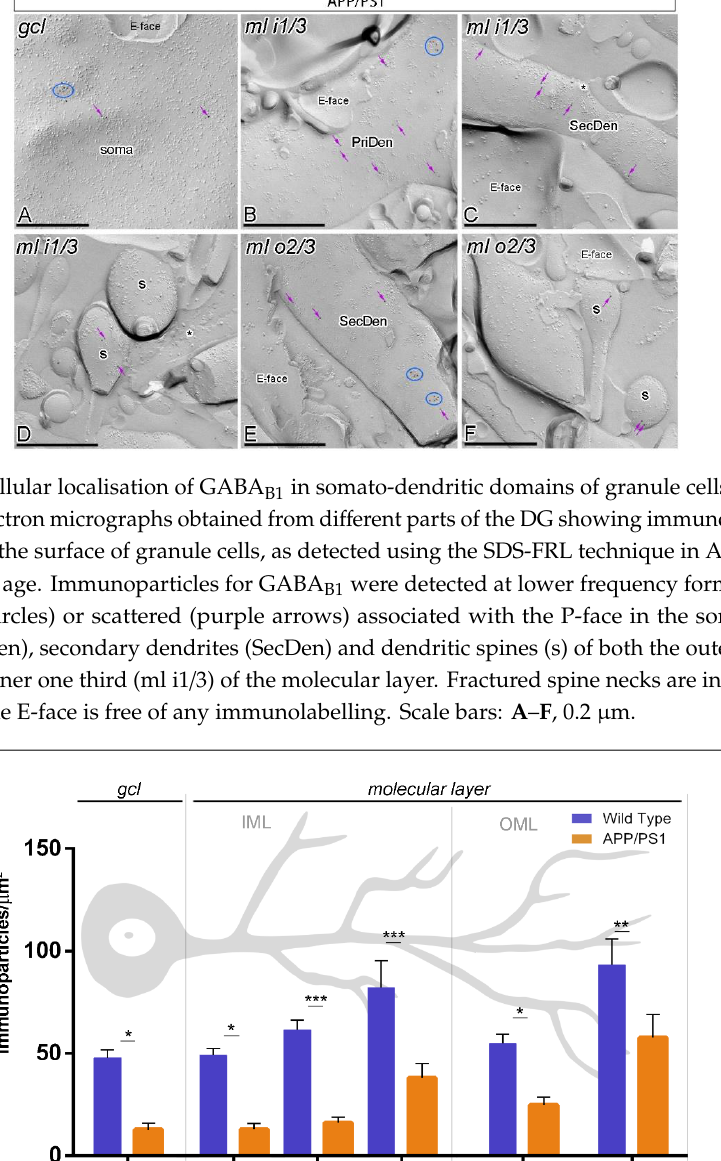
Figure 2. Subcellular localisation of GABA B1 in somato-dendritic domains of granule cells in wild type mice. ( A – F ) Electron micrographs obtained from different parts of the DG showing immunoparticles for GABA B1 along the surface of granule cells, as detected using the SDS-FRL technique in wild type mice at 12 months of age. Immunoparticles for GABA B1 were detected forming clusters (blue ellipses/circles) or scattered (purple arrows) associated with the P-face in the soma, primary dendrites (PriDen), secondary dendrites (SecDen) and dendritic spines (s) of both the outer two thirds (ml o2/3) and inner one third (ml i1/3) of the molecular layer. Fractured spine necks are indicated with asterisks (*). The E-face is free of any immunolabelling. Scale bars: A – F , 0.2 μm.